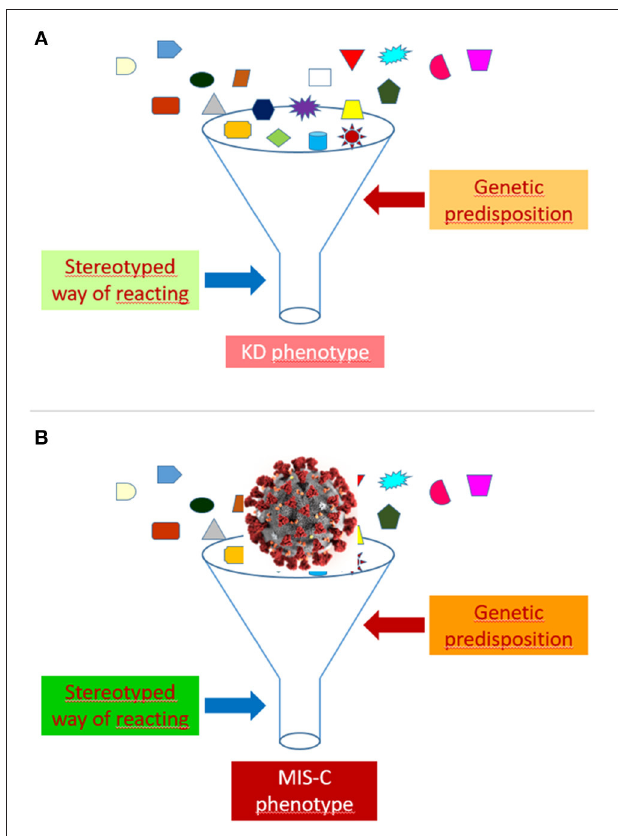
FIGURE 1 | Funnel model of the pathophysiology of Kawasaki disease (KD) (A) and multisystem inflammatory syndrome in children (MIS-C) (B) .